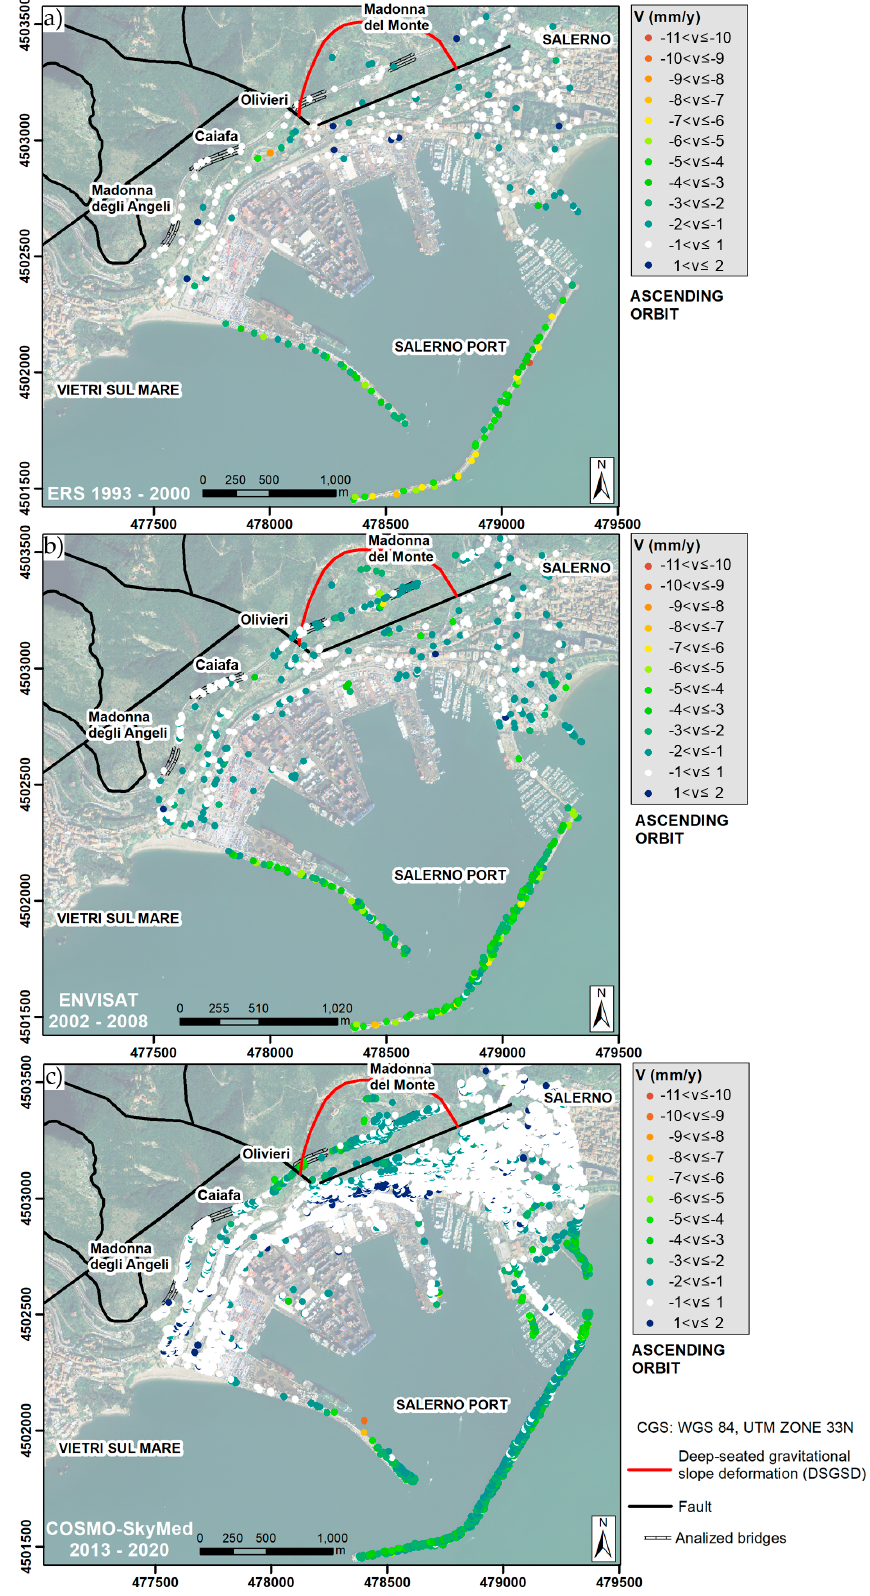
Figure 7. Classified velocity for the displacements from the persistent scatterer interferometry (PSI) analyses computed using the three SAR datasets: ( a ) ERS; ( b ) ENVISAT and ( c ) COSMO-SkyMed. White class represents stable areas.